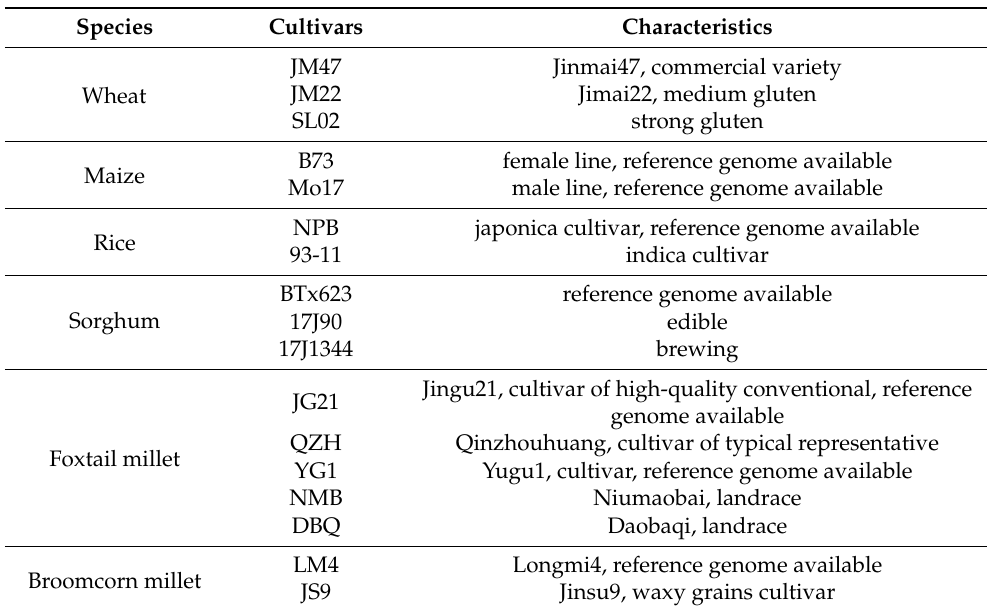
Table 1. The characteristics of plant materials in this